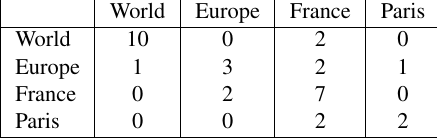
Table 2: Results of geographic extent prediction on the 32 maps of our evaluation